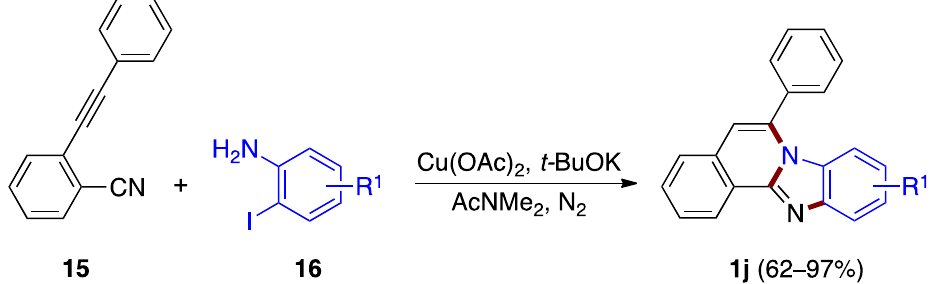
Figure 13. Copper-catalyzed annulation between o -alkynylbenzonitrile 15 and o -iodoanilines 16 .